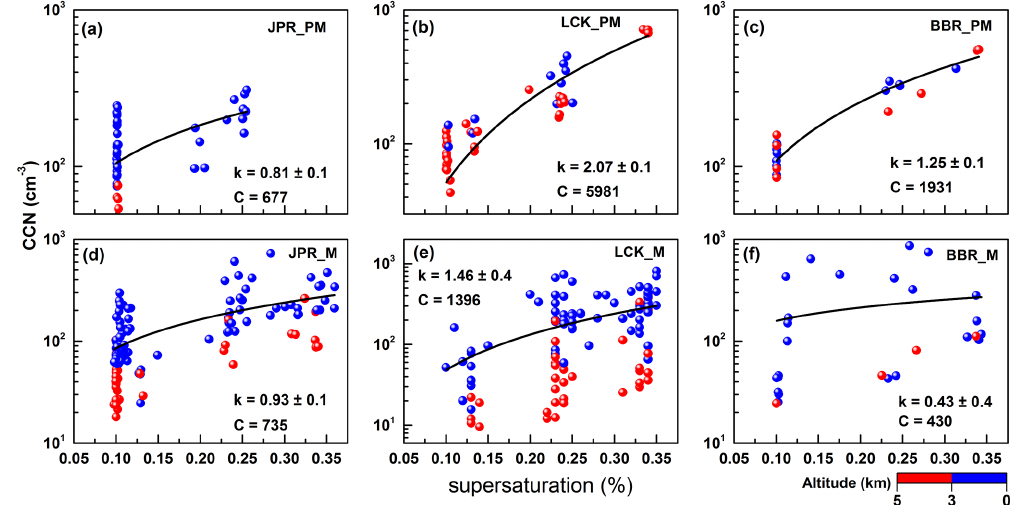
Figure 8. Spatial variation of CCN spectra across the IGP for the western (JPR), central (LCK) and eastern (BBR) IGP regions; (a) , (b) and (c) represent the scenarios prior to the onset of monsoon, while (d) , (e) and (f) correspond to the active monsoon phase. The points are individual measurements; blue colour stands for lower altitudes ( < 3km) and red colour represents the free tropospheric measurements (3 to 5km altitudes). The lines are regression fit to Eq.